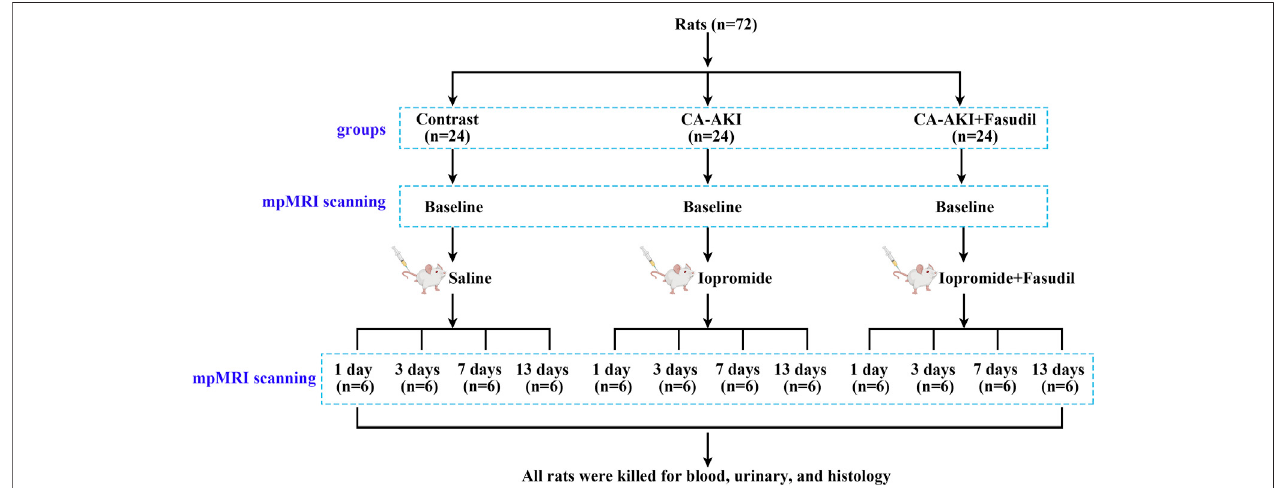
FIGURE 1 | Experimental fl ow chart. Flow chart shows the group designations, and the time points for mpMRI data acquisition, blood, urine, and kidney tissue collections. mpMRI = multiparametric magnetic resonance imaging.